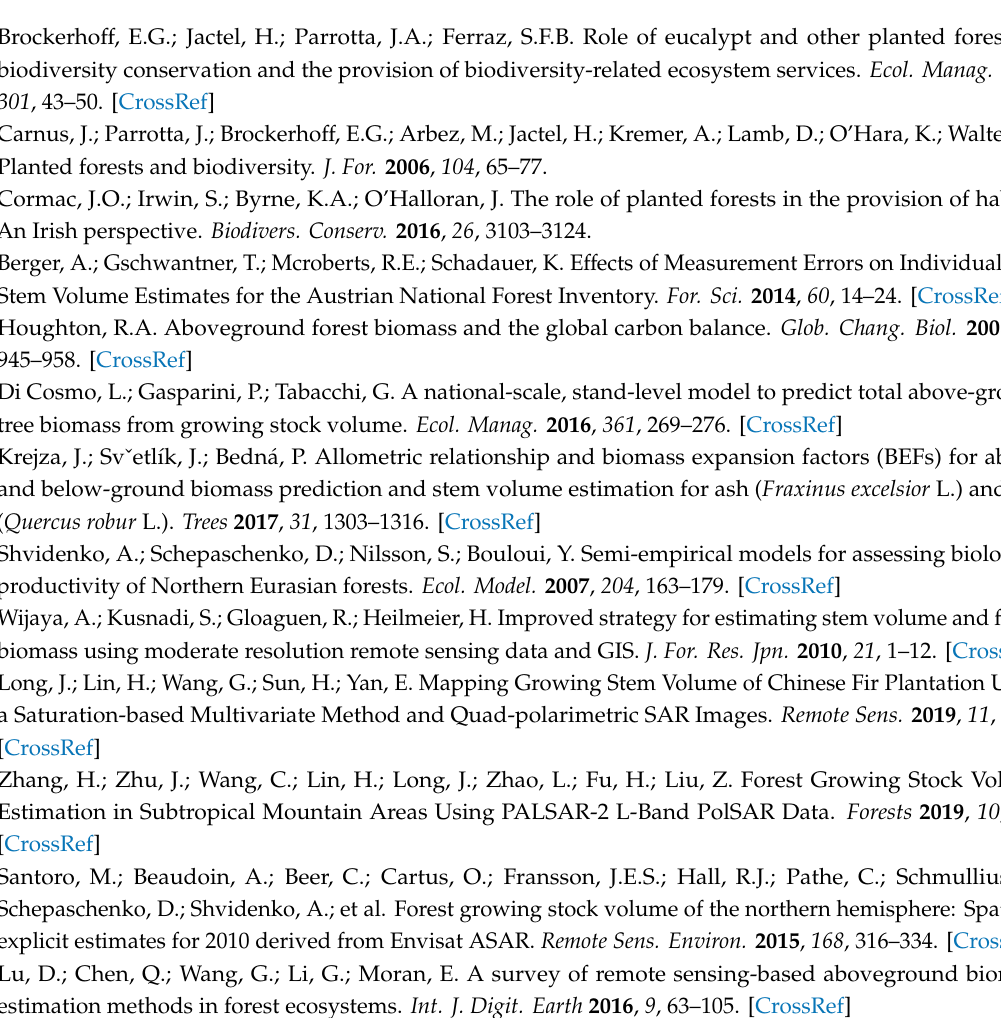
Figure S1: (a) The GF-2 image; (b) the Landsat 8 image; (c) the fusion image Green_Landsat; and (d) the fusion image Red_Landsat. Figure S2: The process of selecting feature variables by the DC-FSCK